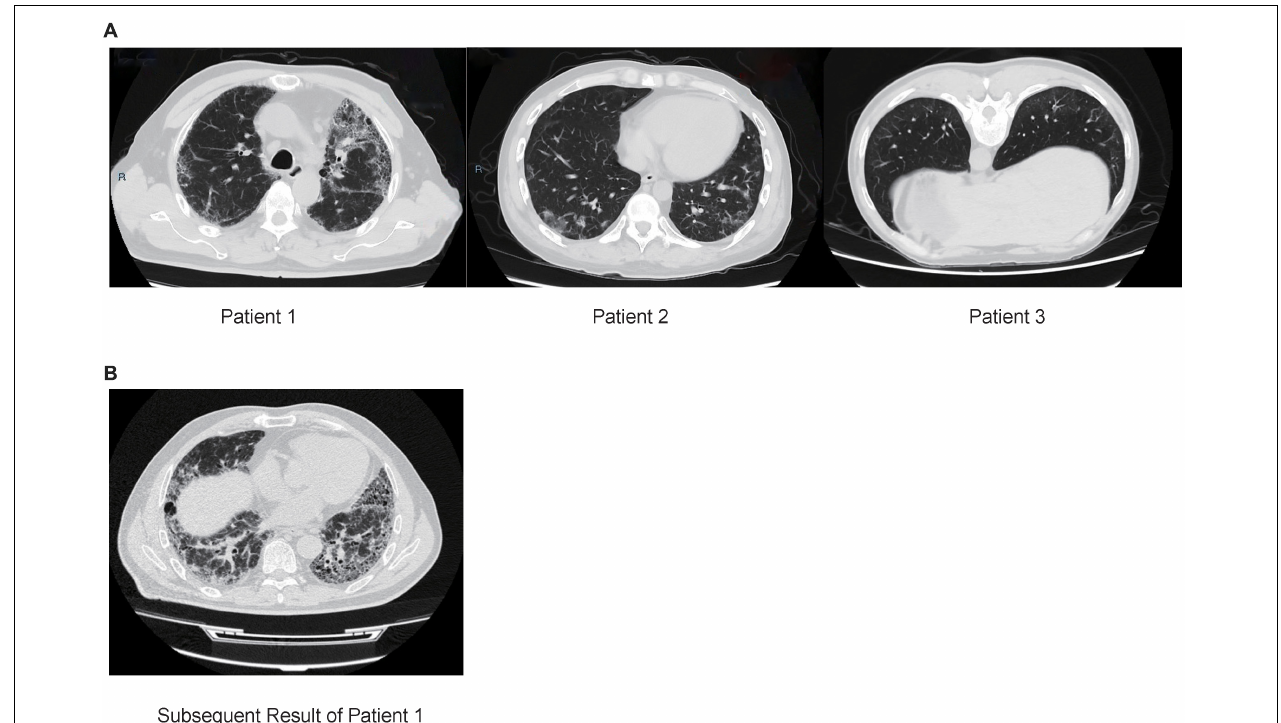
FIGURE 1 | (A) Chest computed tomography (CT) of three patients with interstitial lung disease. Patient 1: CT results of the lower lobes of the lungs under the pleura are shown. Patients 2: CT result showing multiple grid shadows in both lungs. Patient 3: CT results showing subpleural mesh shadow and ground-glass opacity of both lungs. (B) CT result of patient 1 after 5 months, multiple ground-glass patchy shadows and grid honeycomb shadows in both